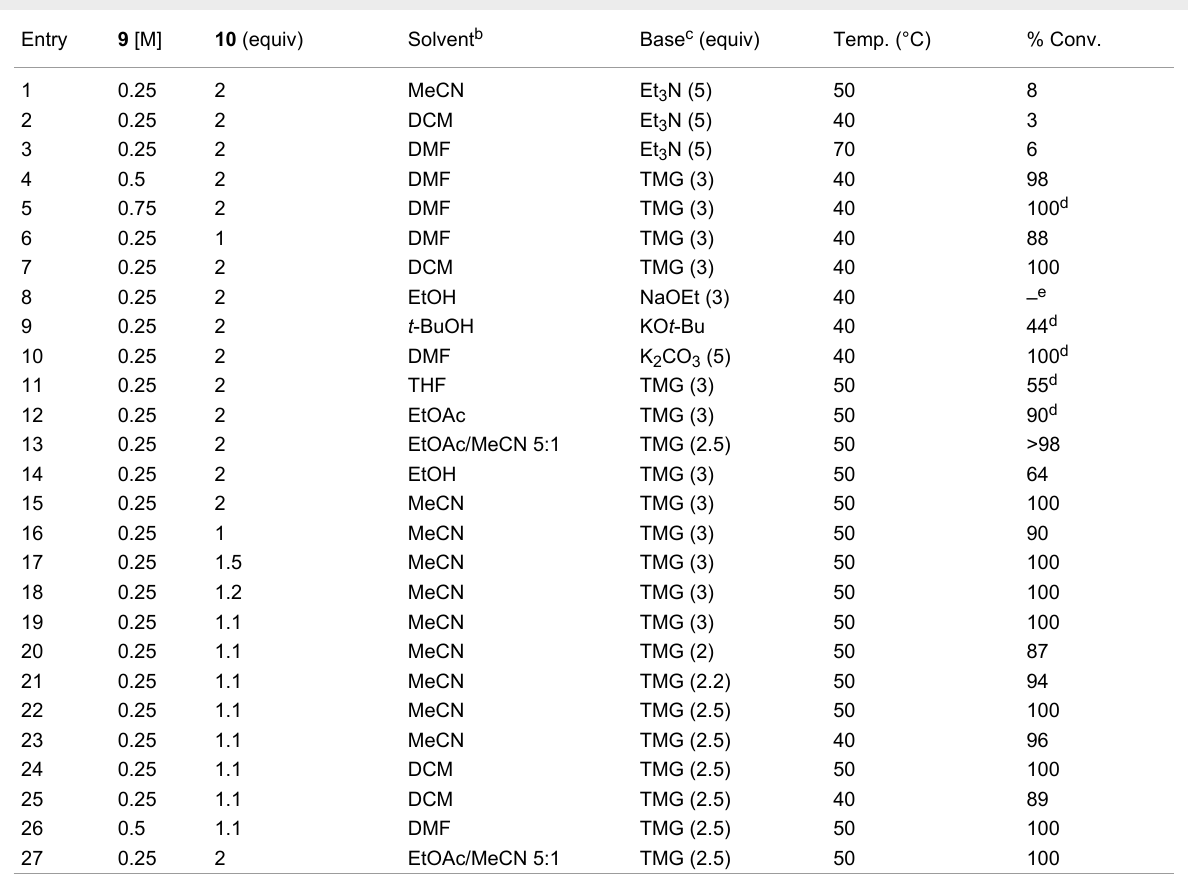
Table 1: Optimisation experiments for S N Ar with ethyl cyanoacetate ( 10 ).